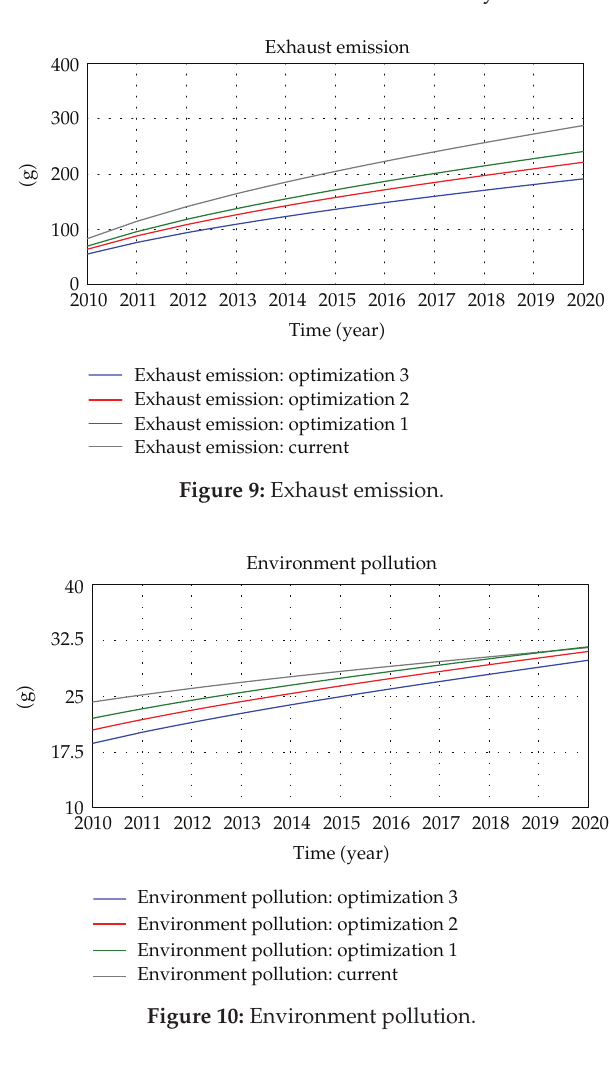
Figure 10: Environment